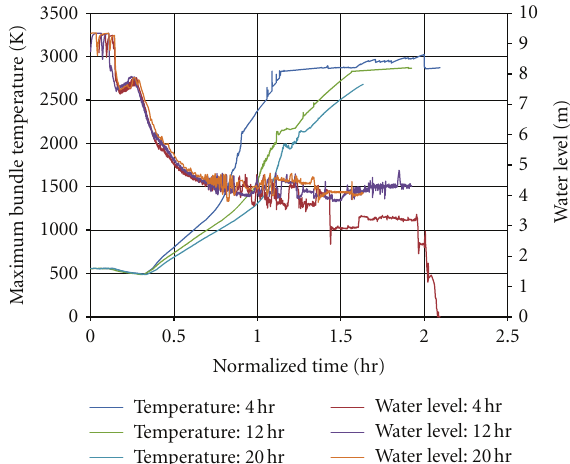
Figure 19: Maximum bundle temperature and water levels for scenarios with depressurization and termination of emergency water injection at 4.2, 11.8, and 19.6 hours after reactor scram (CRD flows maintained).